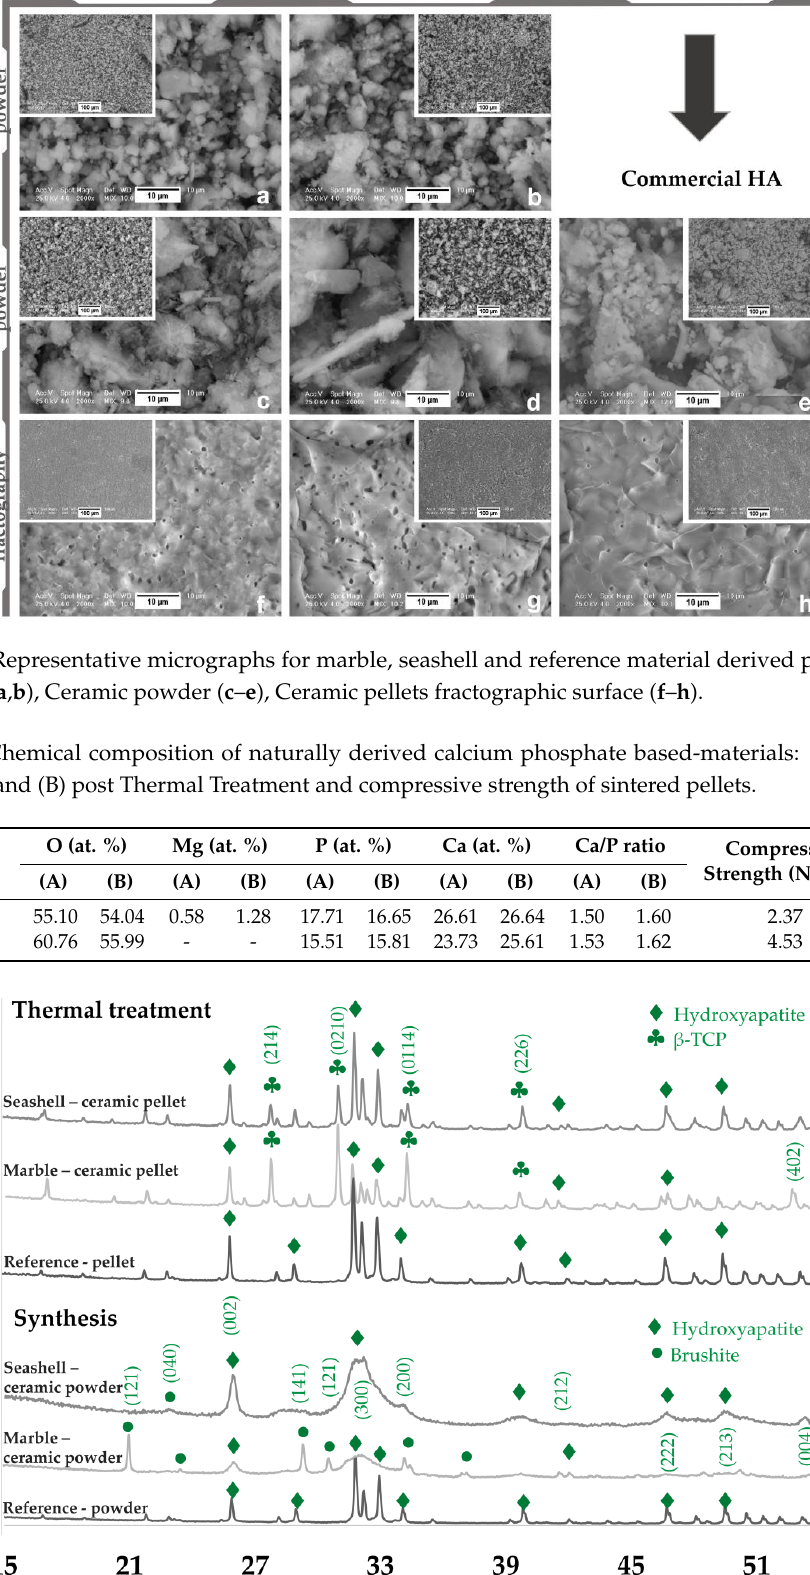
Figure 2. Representative XRD patterns for seashell, marble and reference material derived products.